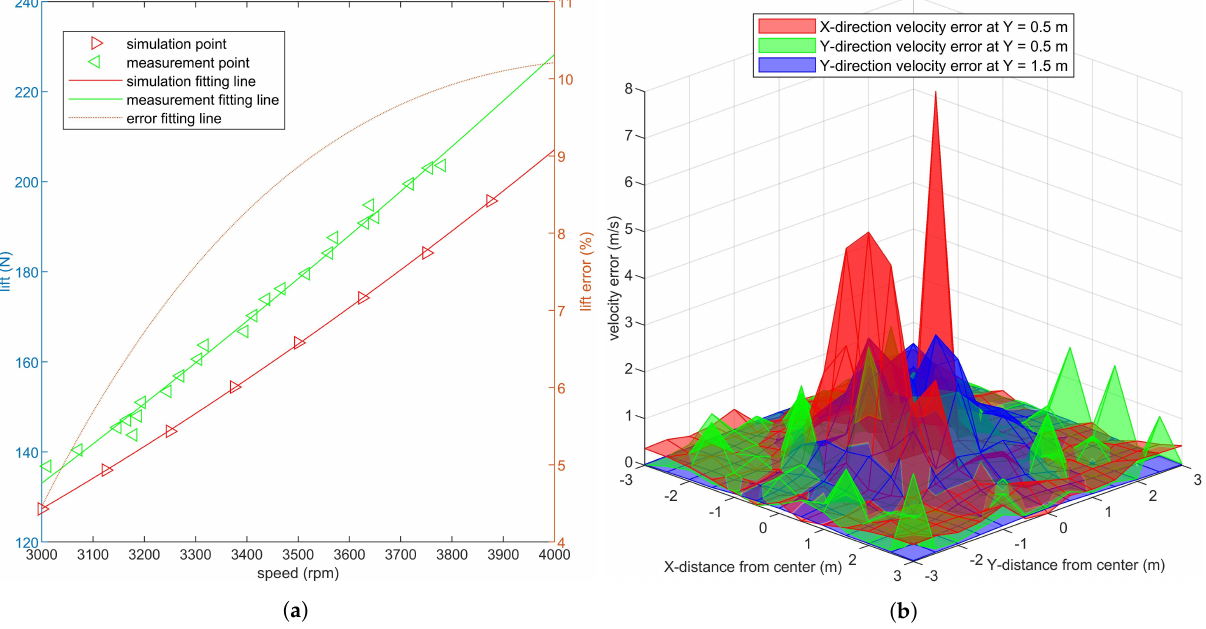
Figure 4. Lift curve and wind field error between the simulation and experiment. ( a ) shows the lift sample points and their fitting curves at different speeds and the error between the experiment and simulation. ( b ) shows the error of X − direction and Y − direction velocities at each sample point on Y = {0.5, 1.5 m} planes between the simulation and